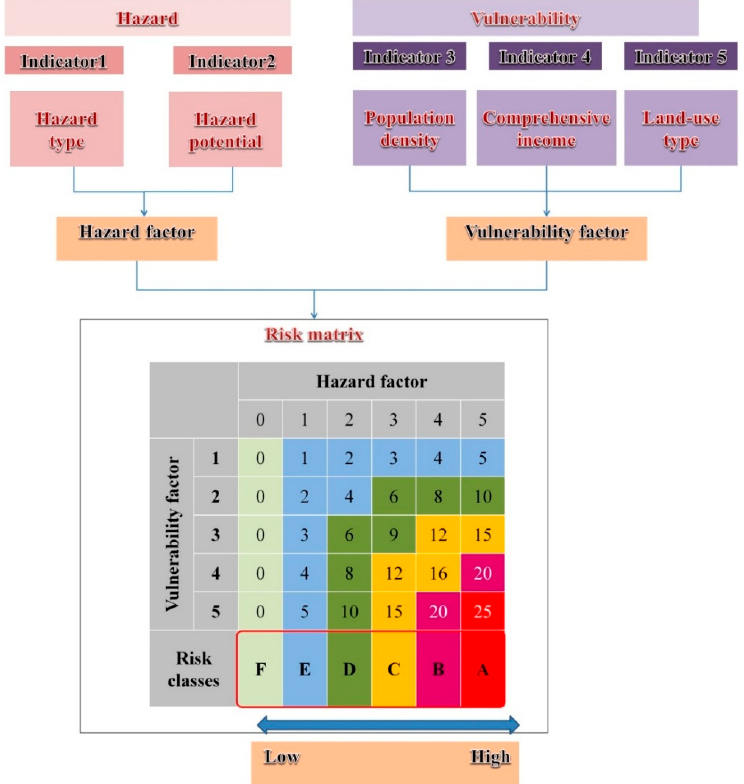
Figure 3. Procedure and framework for coastal risk assessment.